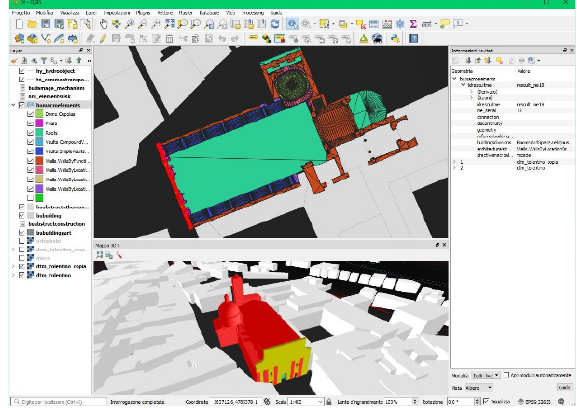
Figure 8. Façade macro-element query and 3D visualization in